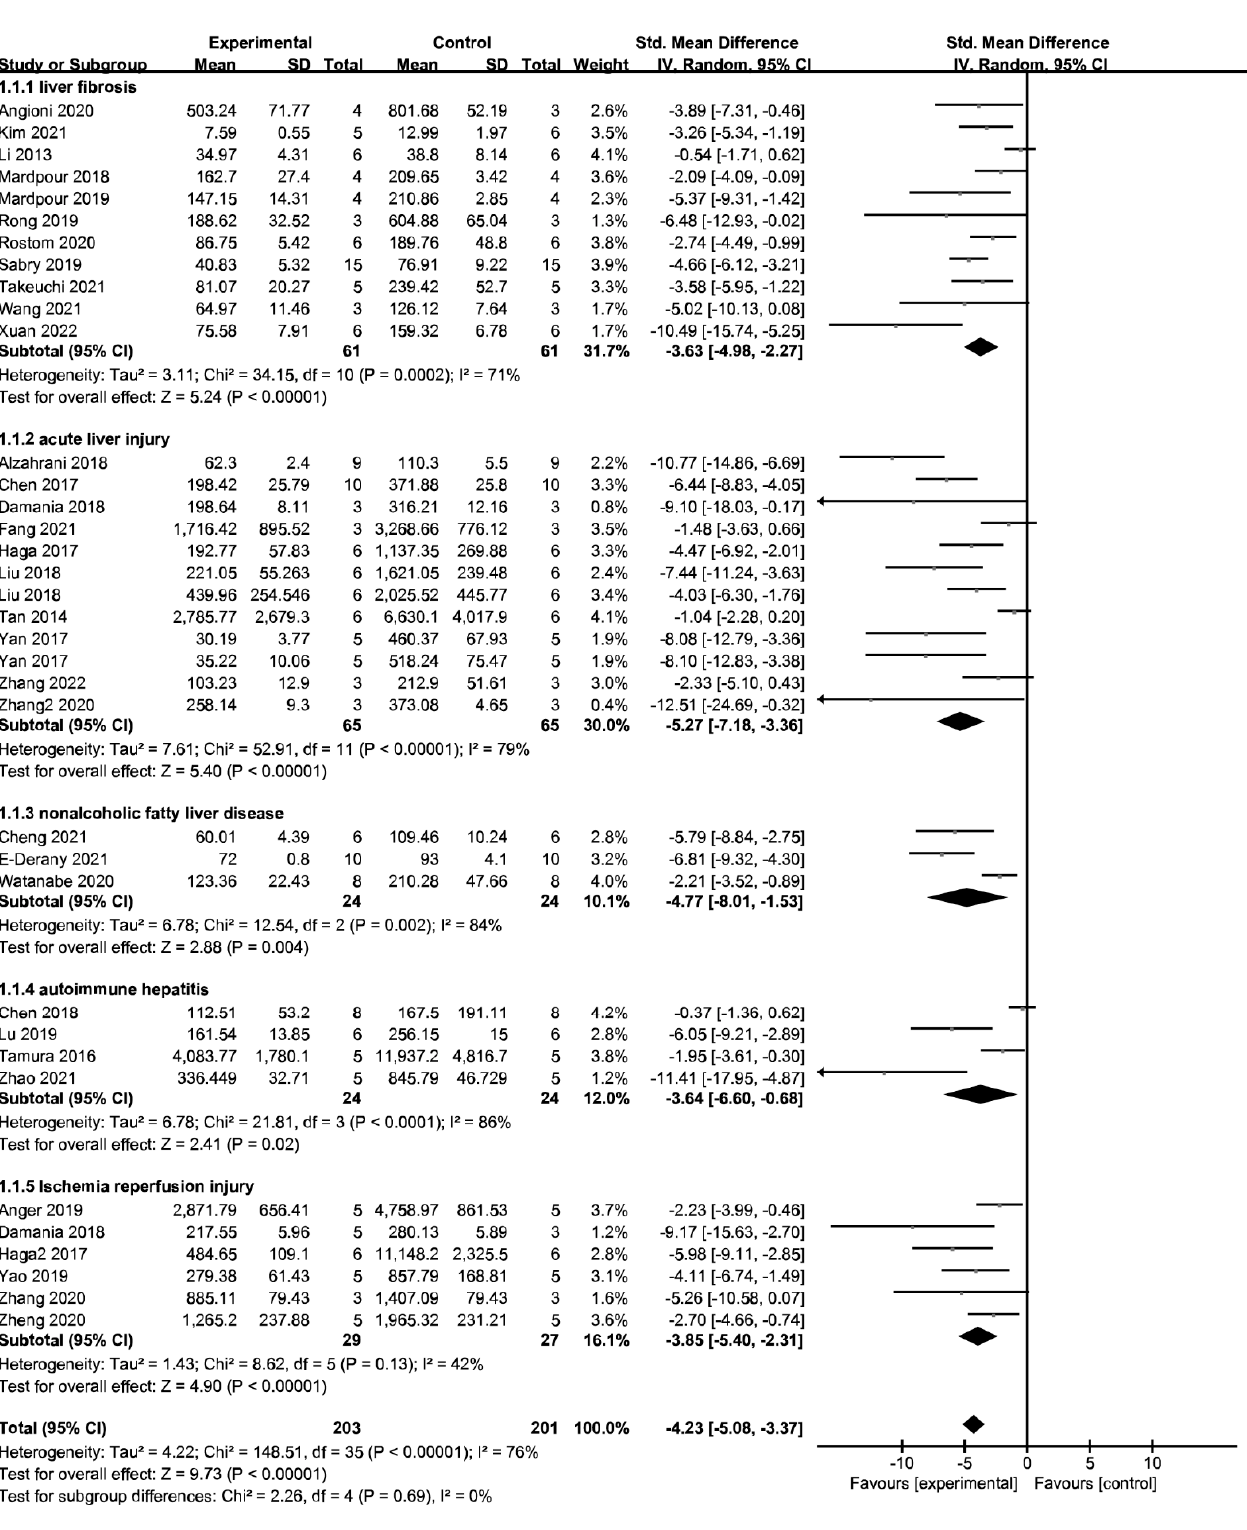
Figure 3. Forest plot of the efficacy of MSC-EV therapy on liver function, alanine aminotransferase (ALT).